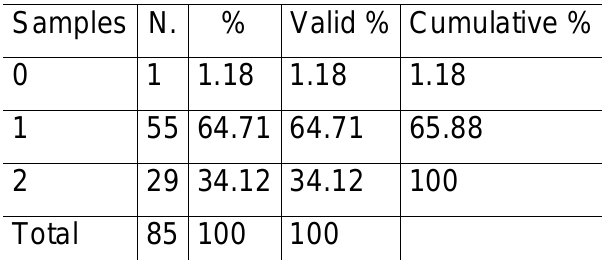
Table 3: Frequency of samples negative or positive for fungi or bacteria in the hydrotherapy units evaluated in two counties from Rio de Janeiro State,